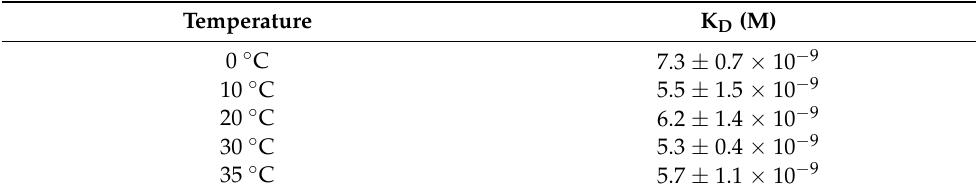
Figure 7. Thermodynamic parameters of E2-DNA complex formation. DNA binding by E2 was measured at indicated temperatures. E2 protein was incubated with 32 P-labeled E2 binding site 1 with increasing concentrations of E2. Five different temperatures were analyzed: ( a ) 0 ◦ C, ( b ) 10 ◦ C, ( c ) 20 ◦ C, ( d ) 30 ◦ C, and ( e ) 35 ◦ C, as indicated. Table 2. Thermodynamic analysis of binding affinities for E2 protein. Each K D was calculated for the temperatures as